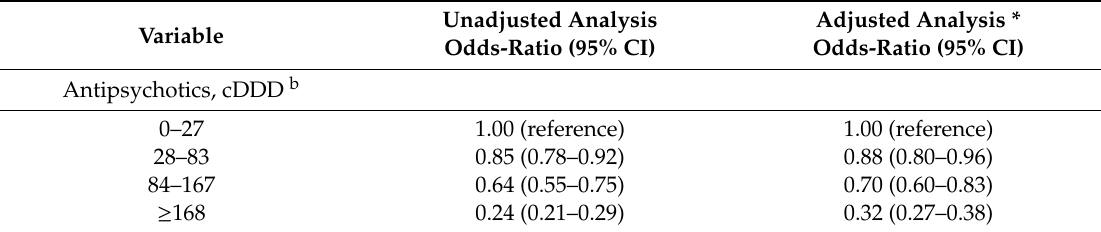
Table 2. Association between use of antipsychotics and risk of colorectal cancer in a population-based case–control study a in Taiwan between 1997 and 2013.